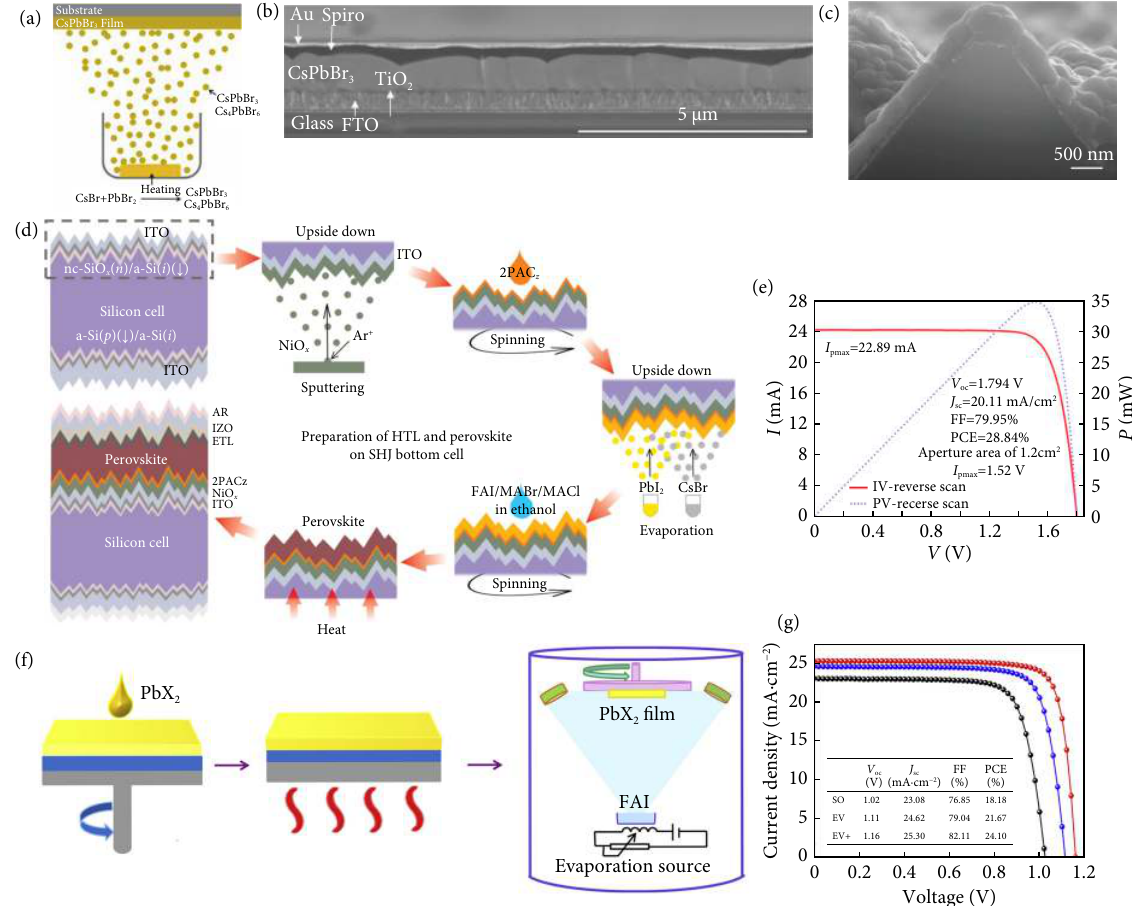
Fig. 3 Single-source evaporation and vapor-solution hybrid protocols for perovskite films. (a) Schematic illustration of single-source evaporation for CsPbBr 3 films. (b) Corresponding cross-sectional SEM images of CsPbBr 3 film. ( a and b ) Reprinted with permission from ref. [39], © 2019 Elsevier B.V. (c) Cross-sectional SEM image of the perovskite deposited conformally on a fully-textured silicon cell. (reprinted with permission from ref. [42], © 2021 Wiley‐VCH). (d) Schematic illustration of vapor – solution deposition method on fully-textured silicon cell. (e) J–V curve and corresponding parameters of tandem cells with an aperture area of 1.2 cm 2 . ( d and e ) Reprinted with permission from ref. [43], © 2022 Wiley‐VCH. ( f and g ) Schematic illustration of vapor-solution hybrid method for MA-free PSCs (f) and J–V curve and corresponding parameters of PSCs (g) (reprinted with permission from ref. [44], © 2022 Elsevier